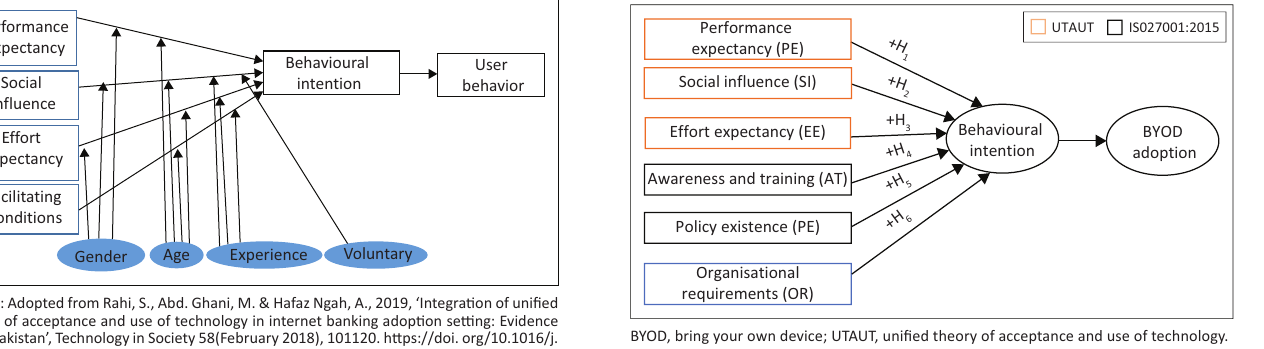
FIGURE 1: The original unified theory of acceptance and use of technology framework.